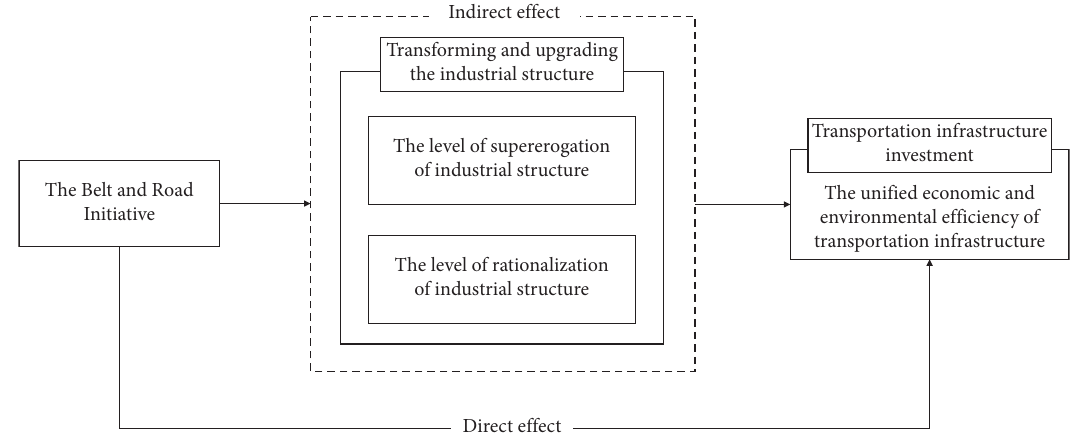
Figure 1: The research framework of this